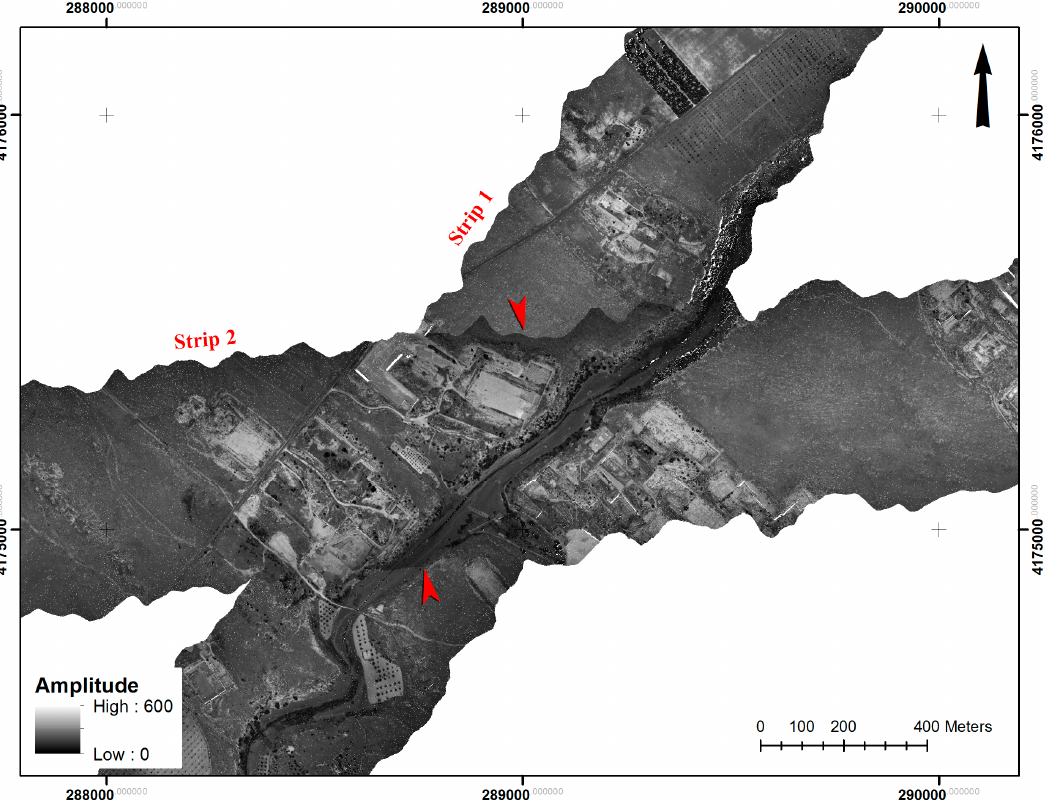
Figure 1. Uncalibrated amplitude map of two overlapping strips. Note the extreme di ff erences between the edge of Strip 2 and Strip 1, as indicated by the red arrows. Visualization: 1 m spatial resolution raster using the median amplitude last echo point values for each cell. Coordinate System: WGS84 UTM Zone